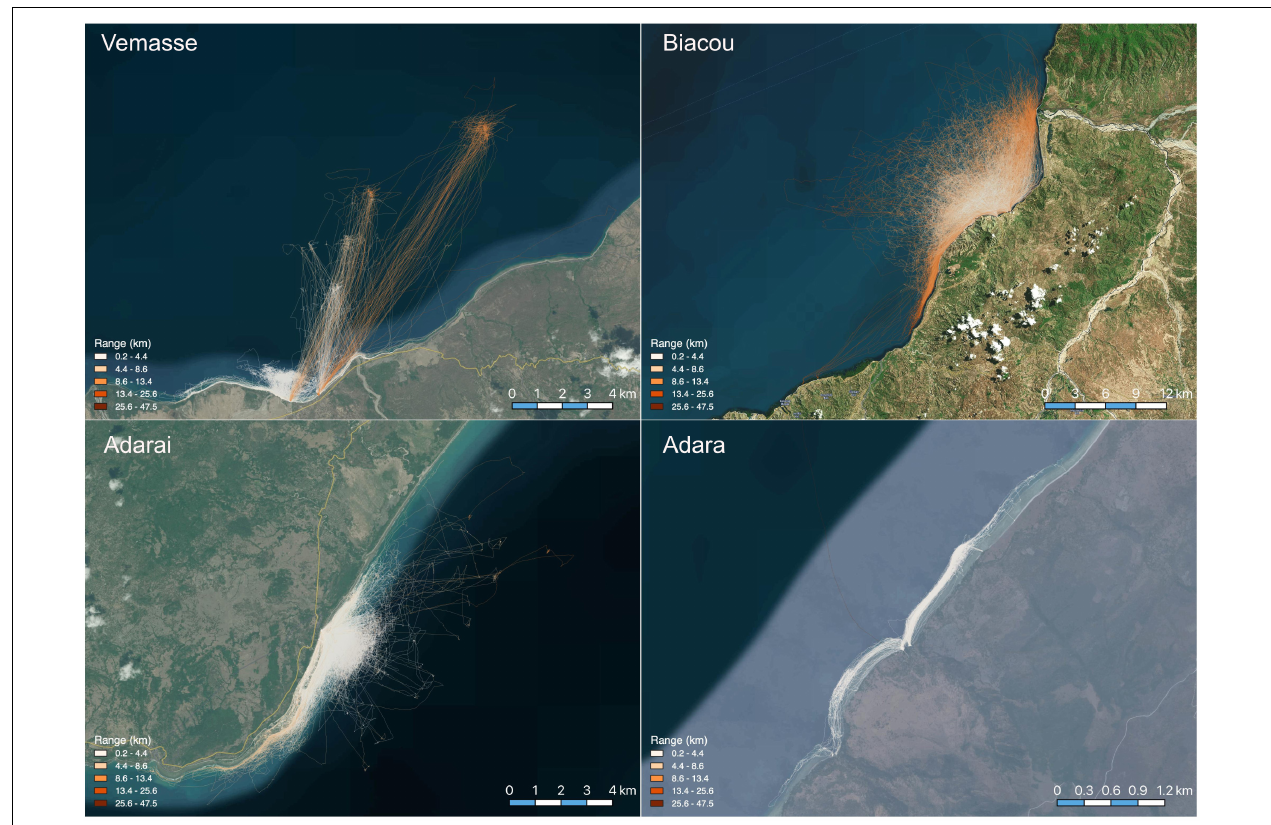
FIGURE 5 | Comparison of fishing behavior and trip range using tracks gathered by solar-powered vessel tracking systems by Pelagic Data Systems in four community sites around Timor-Leste between February and October 2018. The color gradient reflects the trip range, with the longest trips shaded in red and the shortest in white. The number of tracks represented in each pane are Vemasse 437, Biacou 1387, Adara 175, and Adarai 1256 (©Pelagic Data Systems. Satellite imagery©2018